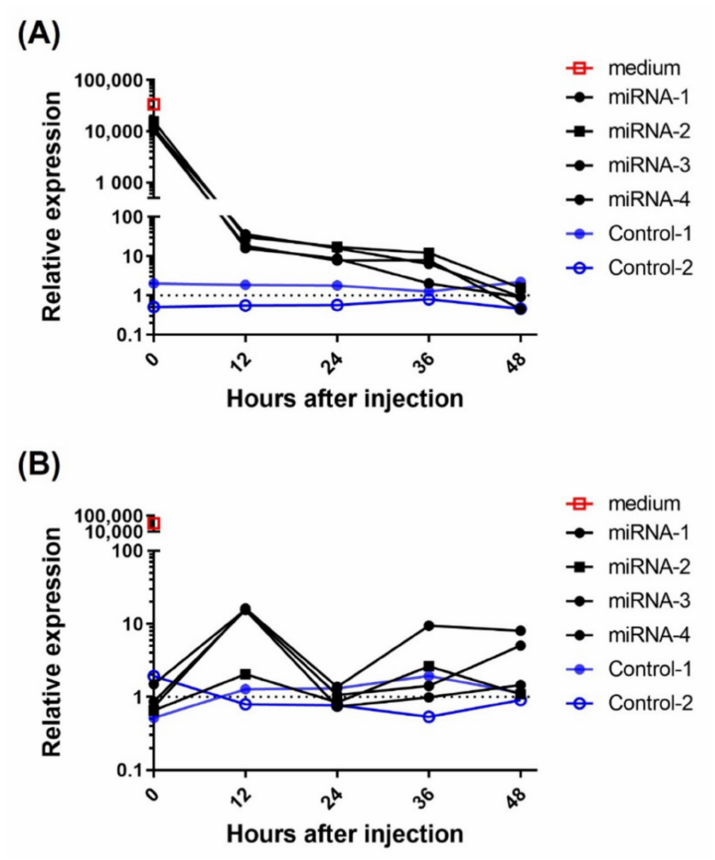
Figure 3. miRNA clearance in vivo. Normal mice were intravenously injected with 200 µ L concen- trated Sec-miR containing medium. The blood and urine samples were collected every 12 h for two days to determine the Sec-miR clearance in vivo. ( A ) Around 25% of Sec-miR expression was detected in the first blood sample (within 2 min after injection) compared to the injected Sec-miR- containing medium. Sec-miR expression in blood was significantly dropped in the first 12 h after injection and remained detectable until 36 h after injection. ( B ) Three of four Sec-miR injected mice showed around 10-fold expressions of Sec-miR in the first 12 h (0–12 h) urine samples. Decreased Sec-miR expressions were found in the second (12–24 h) and fourth (36–48 h) 12 h time period and came back in the third 12 h after